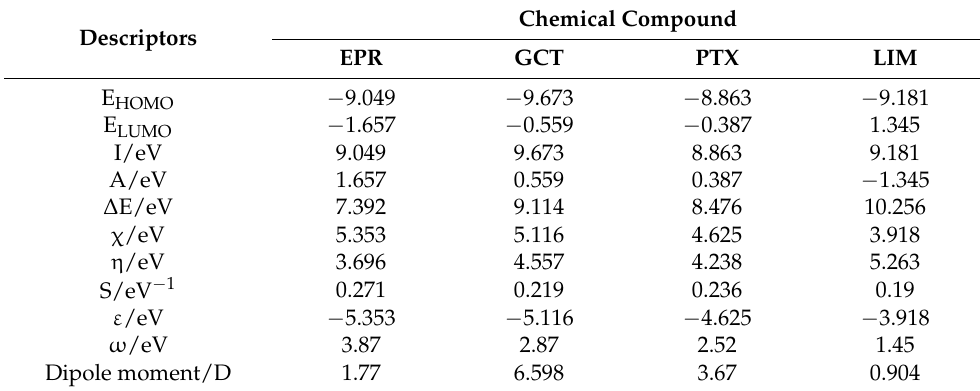
Figure 6. Frontier orbitals, HOMO and LUMO, of the studied compounds. Table 4. Quantum chemical parameters calculated for studied cytostatics and